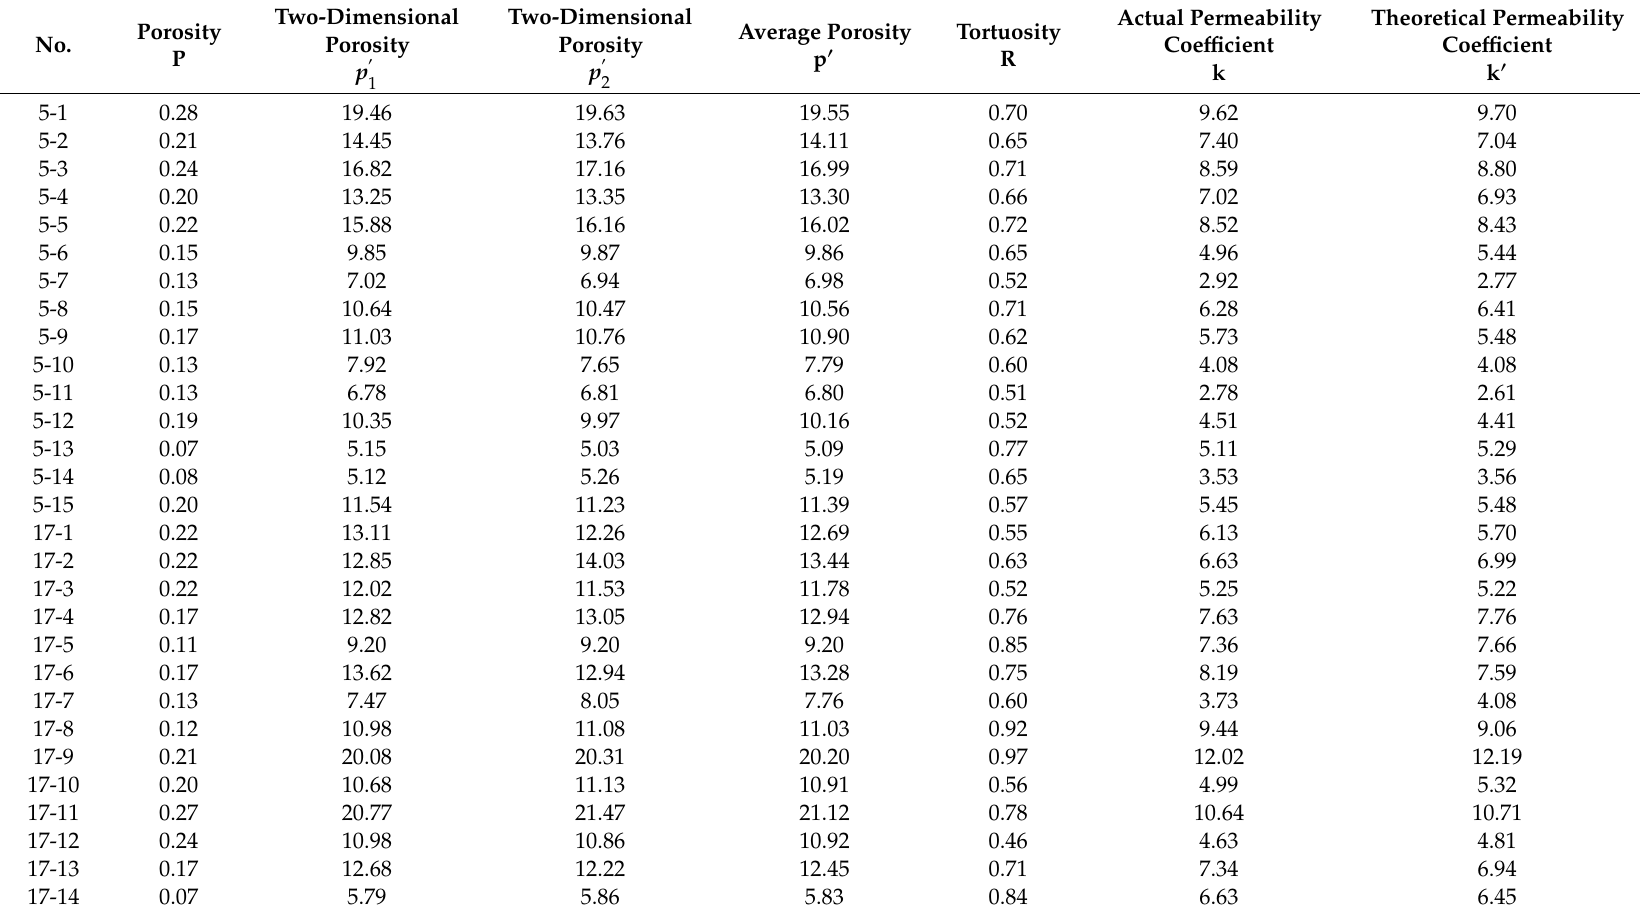
Table 6. Tortuosity calculation